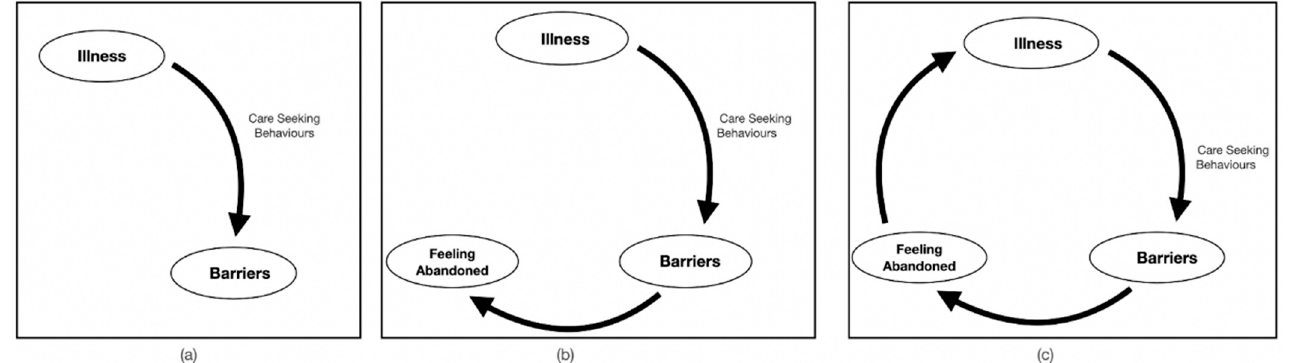
Figure 3. ( a ) Visual depiction connecting theme 1 (a prolonged and debilitating illness) and theme 2 (barriers to care); ( b ) visual depiction of theme 1 and 2 with integration of theme 3 (predominantly negative experiences of care); ( c ) visual depiction of cycle of illness participants found themselves